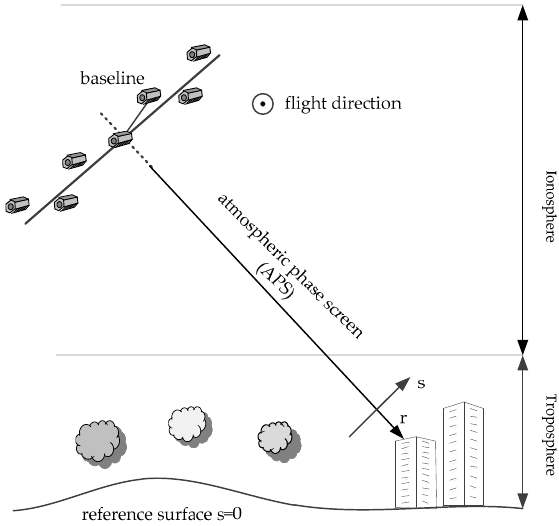
Figure 1. Multipass synthetic aperture radar (SAR) geometry in the range–elevation plane. The coordinate s is referred to as elevation. The satellite flies into the plane and looks to its right.